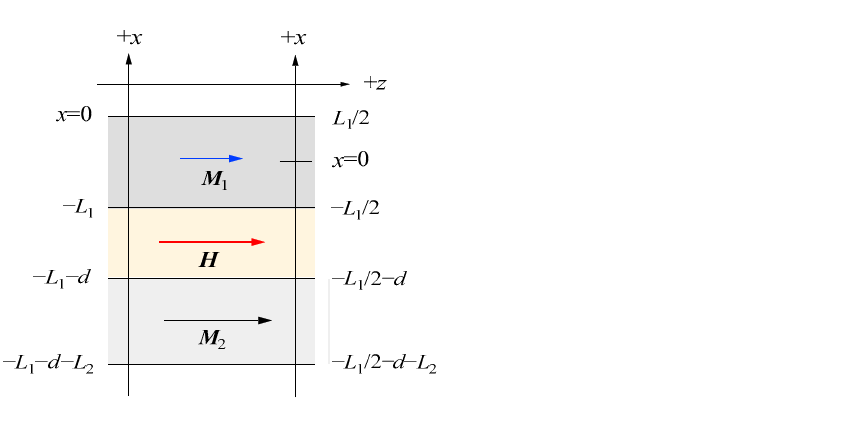
Figure 23. Schematic illustration of a (M1/spacer/M2) trilayer structure and the x -axis setting. We set x = 0 on top of the M1 layer in the first setting and in the center of the M1 layer in the second setting.